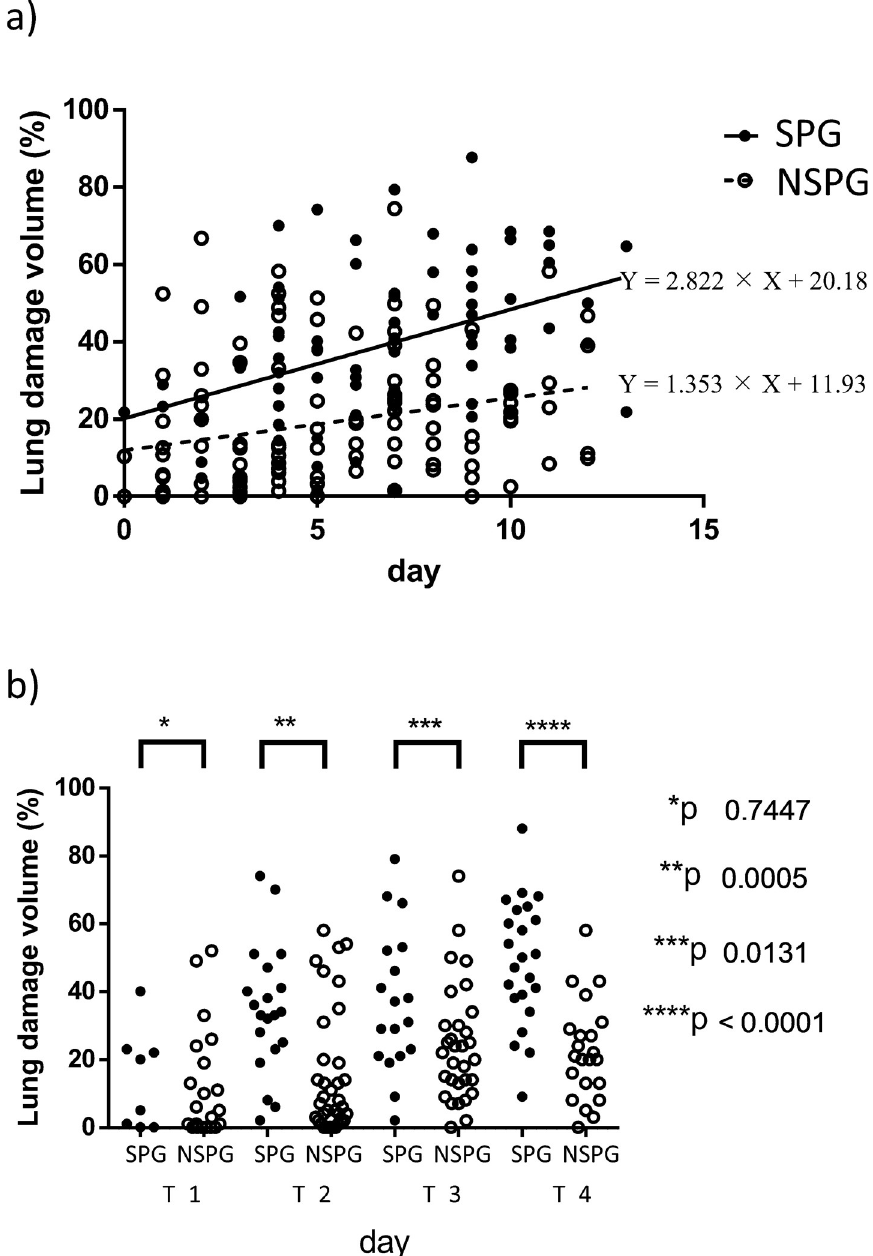
Fig 4. Comparison of the extent of lung damage according to time after onset. a) The time from onset and extent of lung damage in the SPG and NSPG. b) Comparison according to time. T1 period: from onset until day 2. T2 period: from day 3 to 5. T3 period: from day 6 to 8. T4 period: from day 9 to 11.